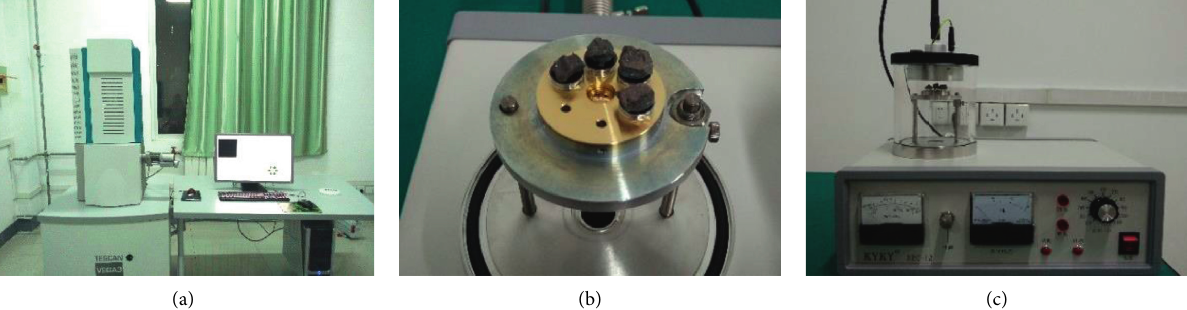
Figure 3: SEM analysis of the concrete samples. (a) Scanning electron microscope. (b) Samples for analysis. (c) Gold spraying